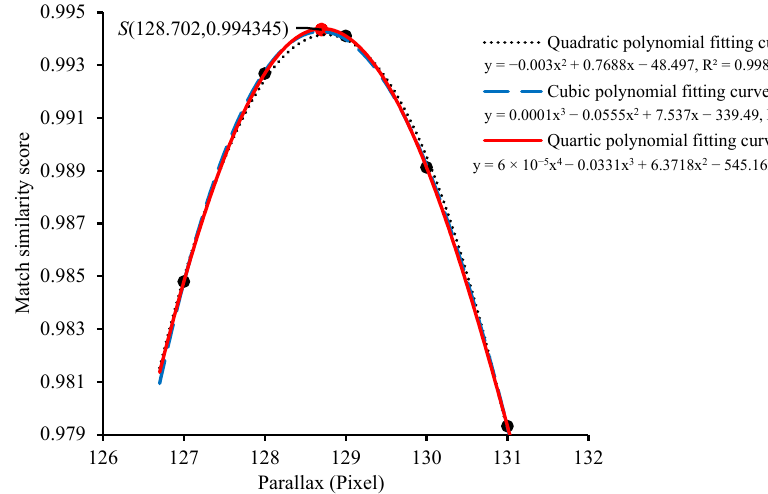
Figure 13. Polynomial fitting curves of disparity and similarity.